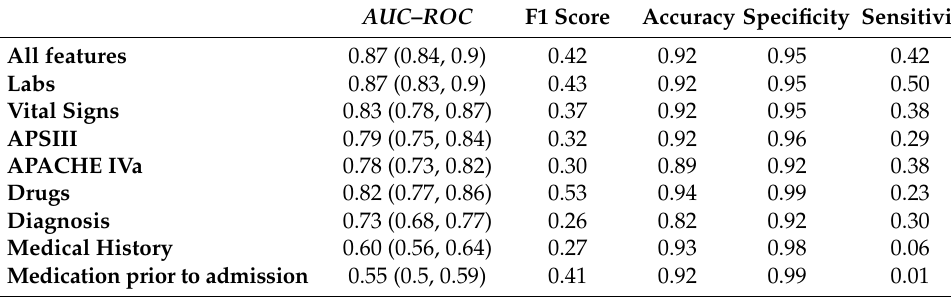
Table 2. Detailed metrics of performance for the predictive models of early mortality in patients with thrombosis from the eICU dataset